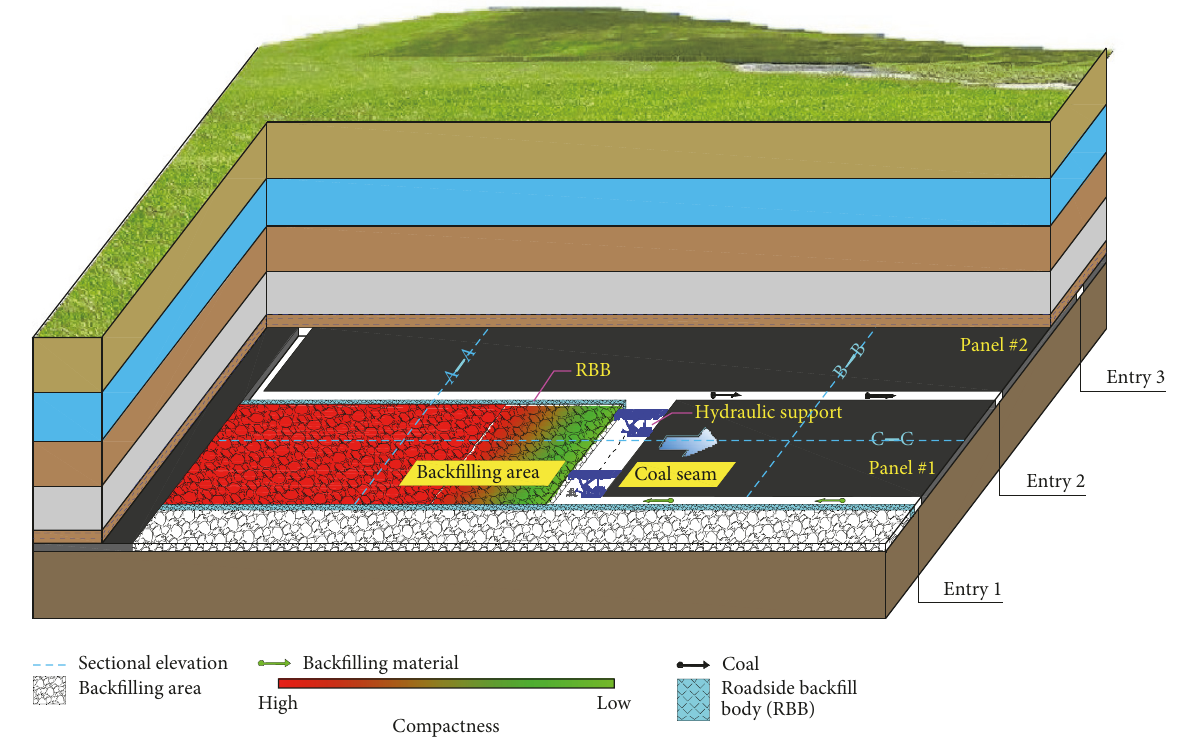
Figure 1: Working face layout of GER with fully mechanized gangue backfilling